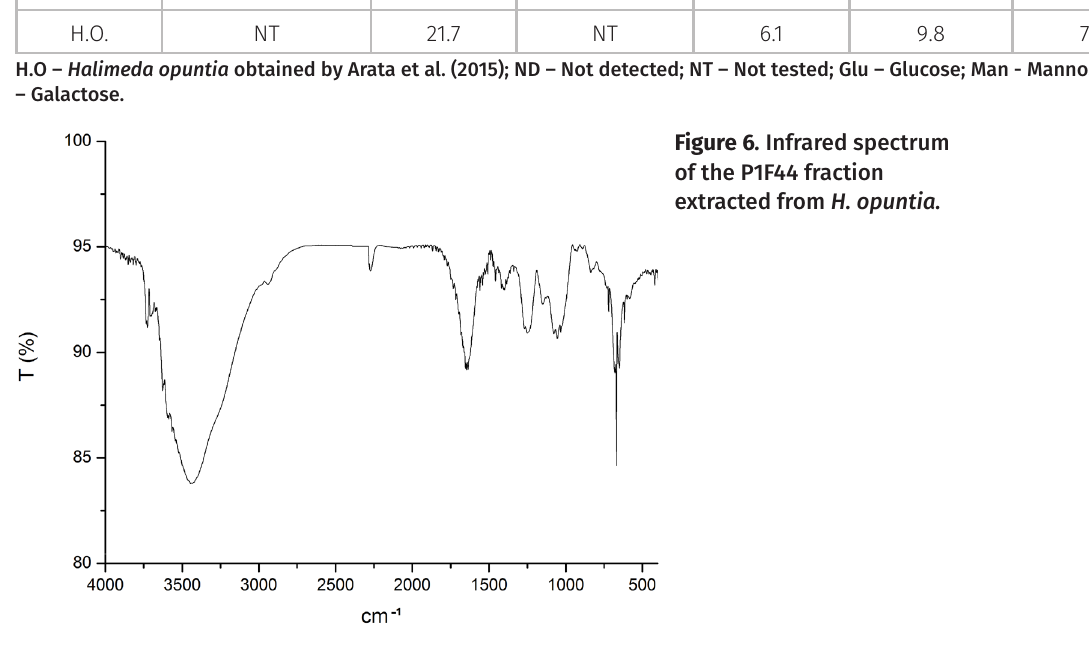
Table IV. Infrared spectrum attributions of the SP obtained from H. opuntia.